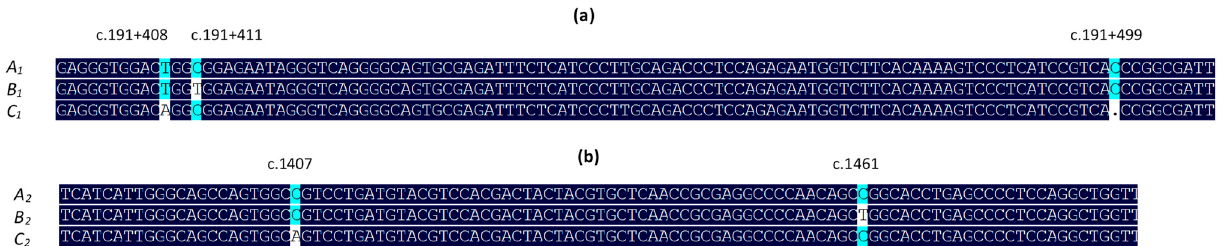
Figure 1. Banding patterns for PCR-SSCP analysis of a fragment of intron 1 ( A ) and a fragment containing exon 17 ( B ) of DGAT1 . The homozygous genotypes and some heterozygous genotypes for each region are shown.